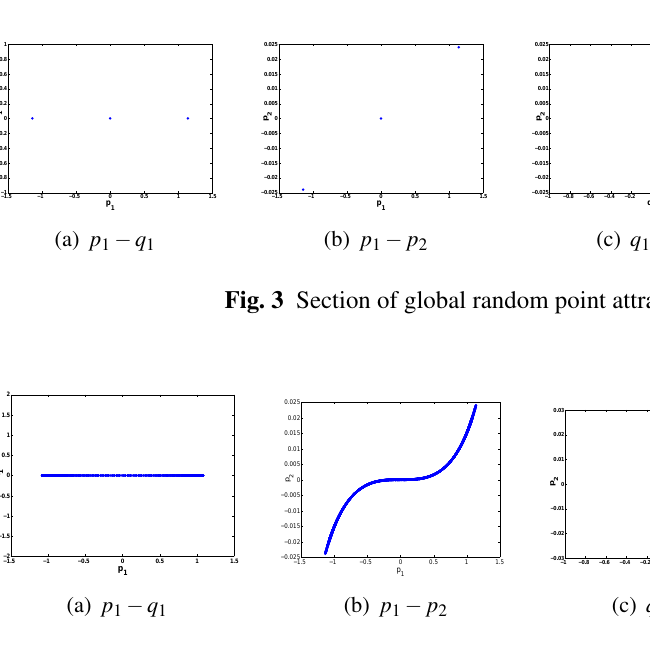
Fig. 4 Section of global random attractors for ϕ NGM 3 with case